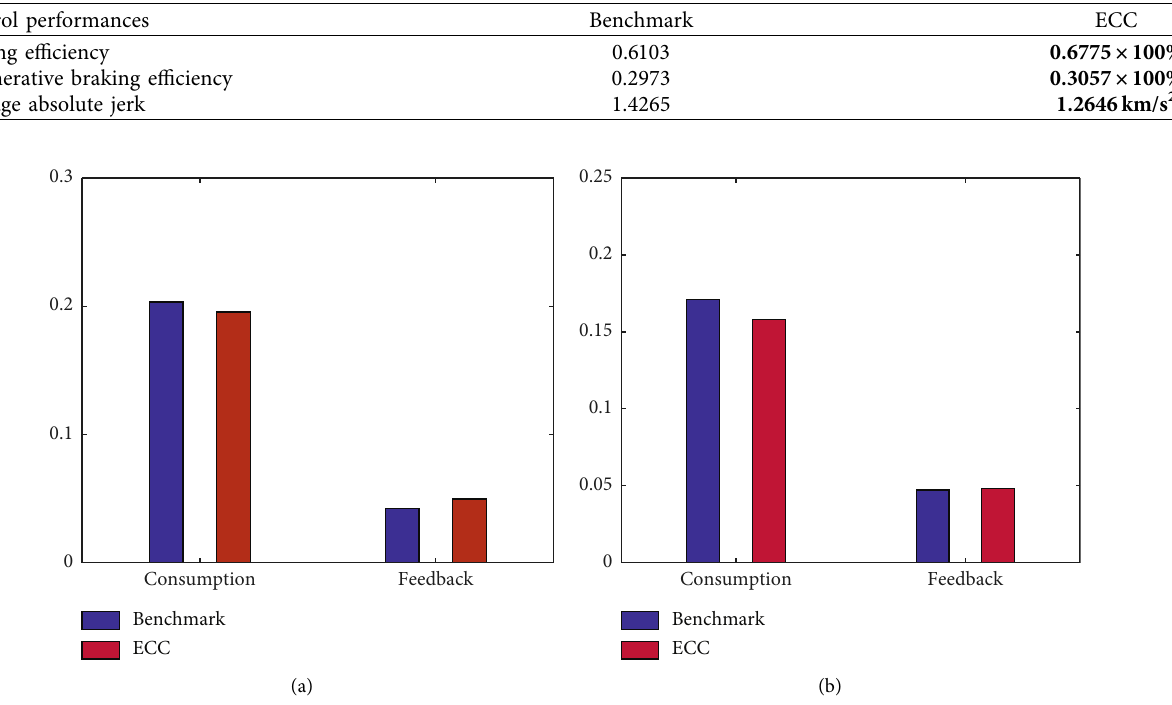
Figure 12: Results of energy consumption and feedback (kwh). (a) At 40km/h. (b) At 80